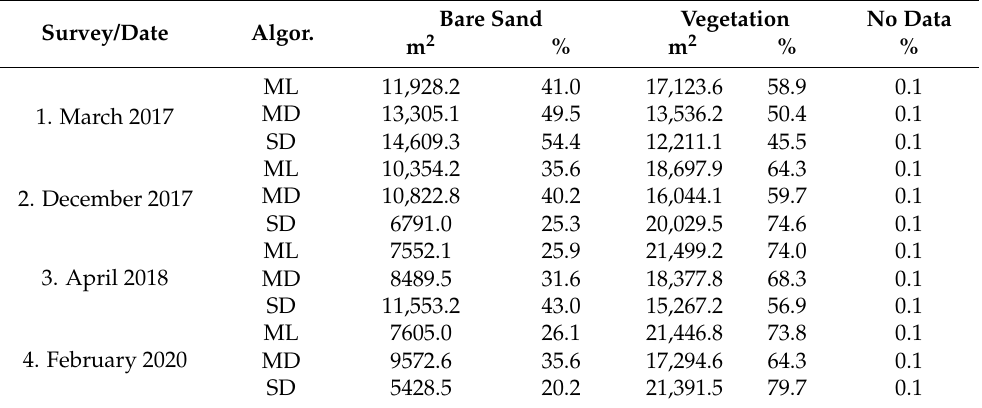
Table 4. Semi-automatic classification results in terms of m 2 and percentage. The results from all the three algorithms are reported.